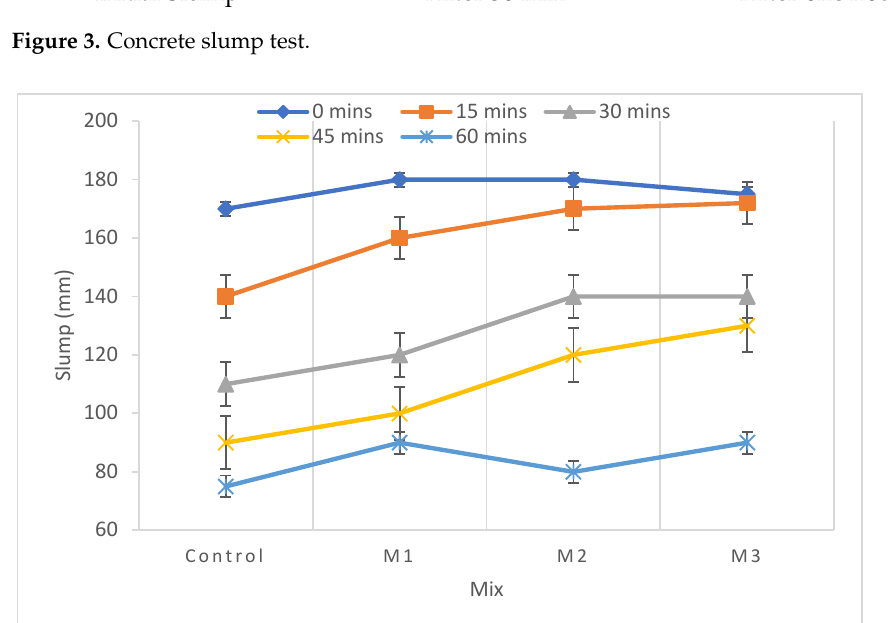
Figure 4. Variation in workability. Table 4. Concrete properties in a fresh state.